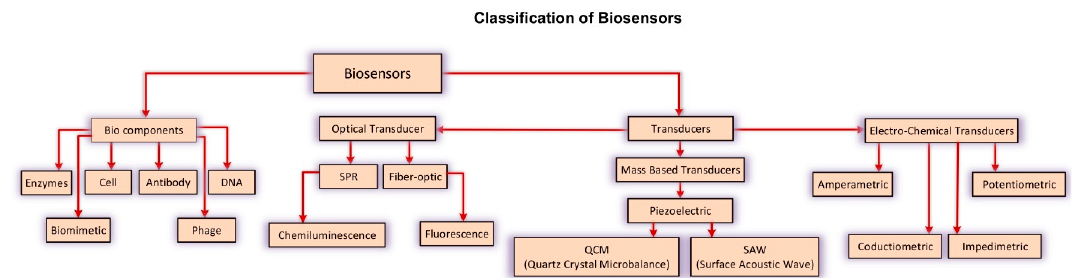
Figure 2. Schematic representation of the components involved in a biosensor devise.